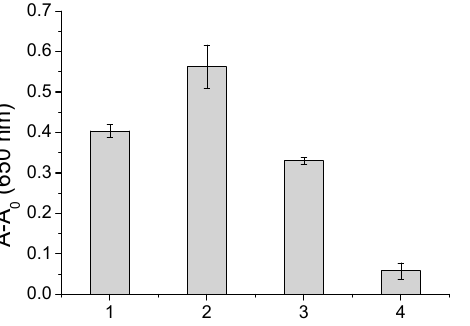
Figure 3. Effect of DNA sequence on the colorimetric detection for CH 3 Hg + . AuNPs, 0.6 nM; CH 3 Hg + , 100 nM. TMB, 1.0 × 10 − 3 M; H 2 O 2 , 1.5 M; pH, 4.5; and incubation time, 25 min.